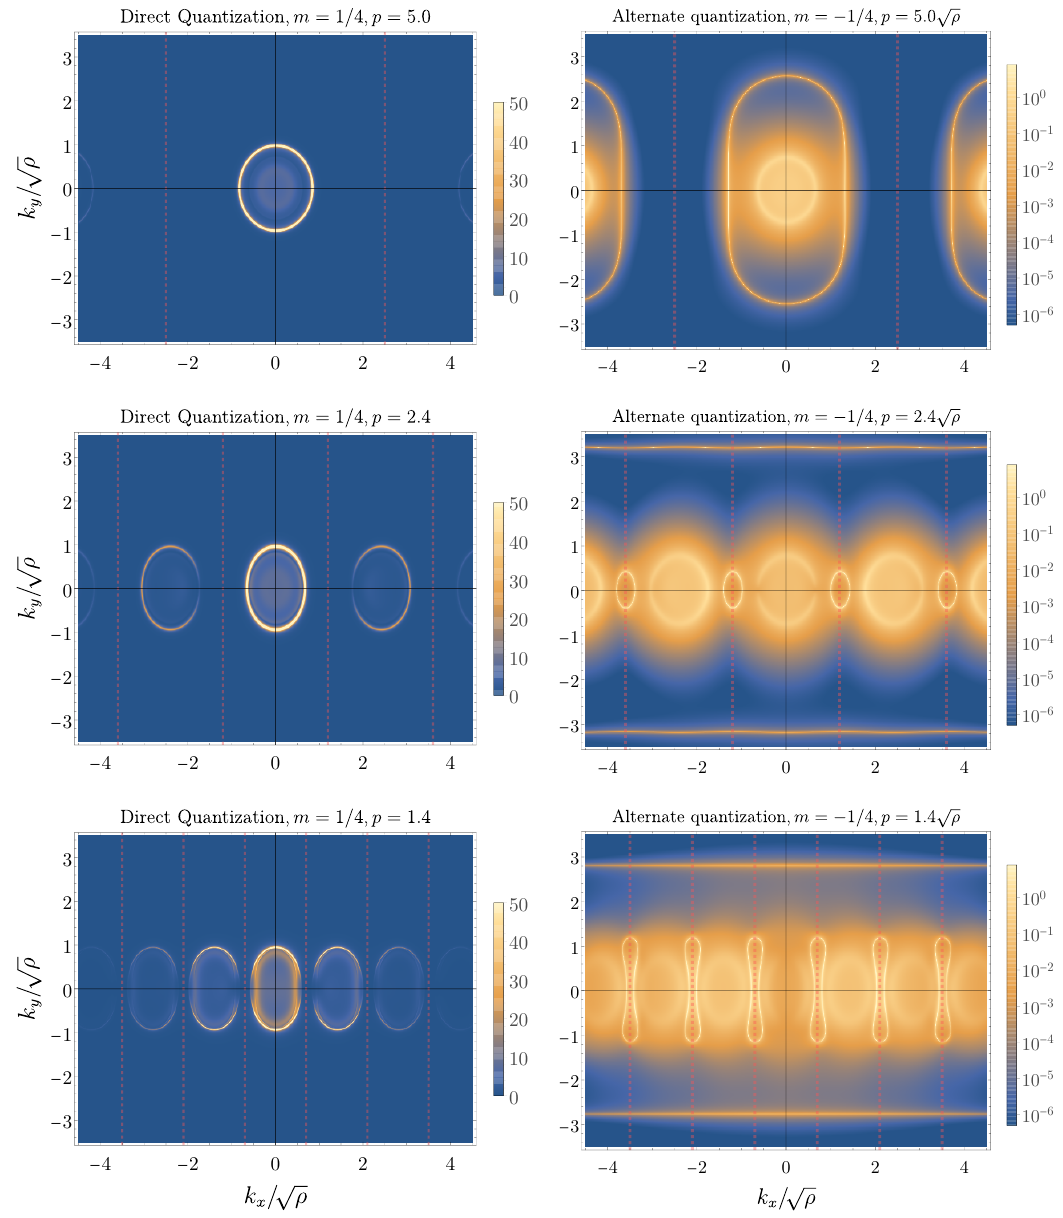
Figure 6 . The fermionic spectral density in the holographic model with strong unidirectional peri- p odic potential ( (cid:21) = 8 : 0 ) , in direct and alternate quantizations near the Fermi level ( ! = 0 : 01 (cid:26) ). The squeezing of the outer Fermi surface happens like in the toy model on (cid:12)gure 1. In the Alt. quantization, where the Fermi surfaces are larger, the outer FS breaks apart in a band at k y (cid:25) (cid:6) 3, and a pocket at the BZ boundary due to Umklappendix When the BZ boundary is brought closer, p to p = 1 : 4 (cid:26) , the spectral density appears to be drastically reduced in the direct quantization near the Umklapp surface. In the alternate quantization, dumbbell shapes similar to the non-interaction p p model in (cid:12)gure 1 appear. The background parameters are T = 0 : 01 (cid:26) and p = 5 (cid:26); (cid:22) 2 = (cid:26)= 0 : 54 p p (top); p = 2 : 4 (cid:26); (cid:22) 2 = (cid:26)= 1 : 22 (middle); p = 1 : 4 (cid:26); (cid:22) 2 = (cid:26)= 2 : 04 (bottom).